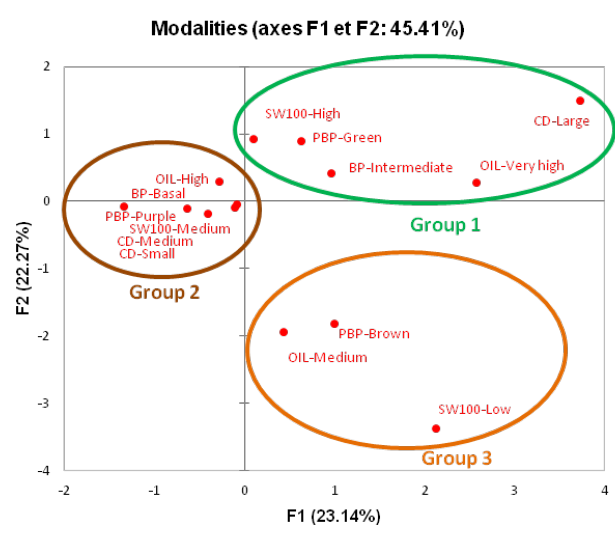
Figure 3. Association of modalities of traits in the ½ plan of the multiple cor- respondence analysis (MCA) (45.41%) . BP : branching pattern, PBP : petiole base pigmentation, OIL : oil content, SW100 : 100-seed